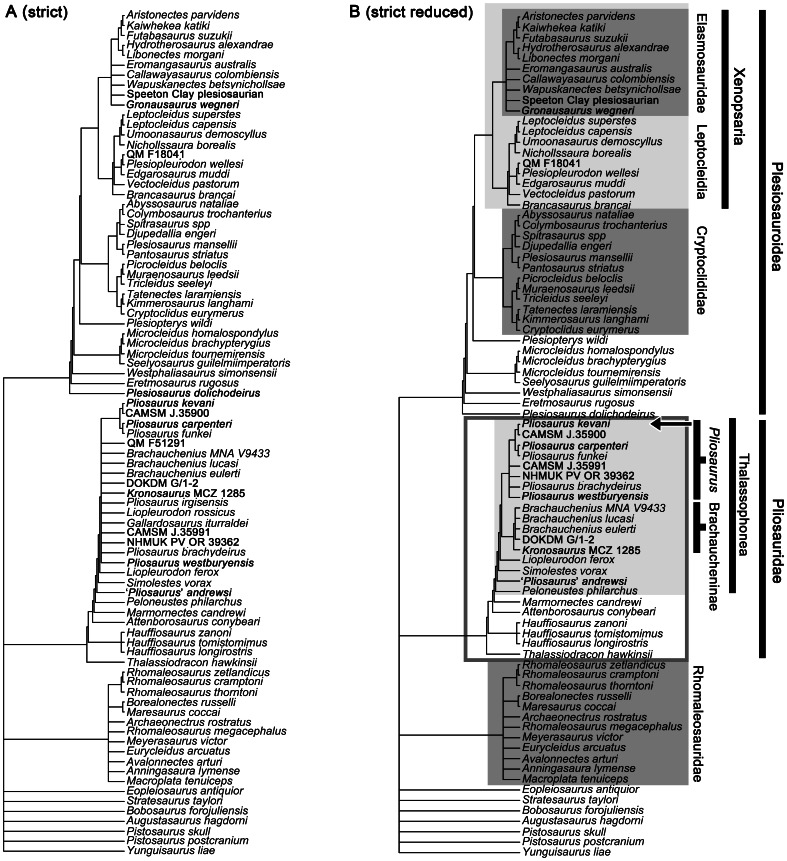
Phylogenetic position of Pliosaurus kevani n. sp. DORCM G.13,675.Strict (A) and strict reduced (B) consensus topologies of >130000 shortest length trees 1336 steps long resulting from analysis of our matrix of 85 taxa and 270 characters modified from [26]. Shading is used to indicate major clades, Pliosauridae is enclosed by a grey rectangle, and Pliosaurus kevani n. sp. is indicated by an arrow.